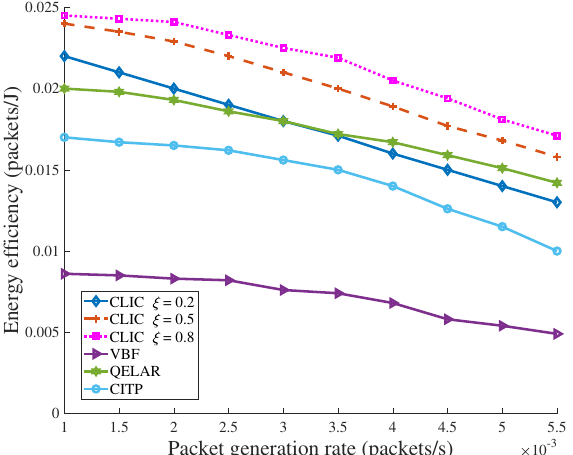
Figure 14. Comparison of energy efficiency versus packet generation